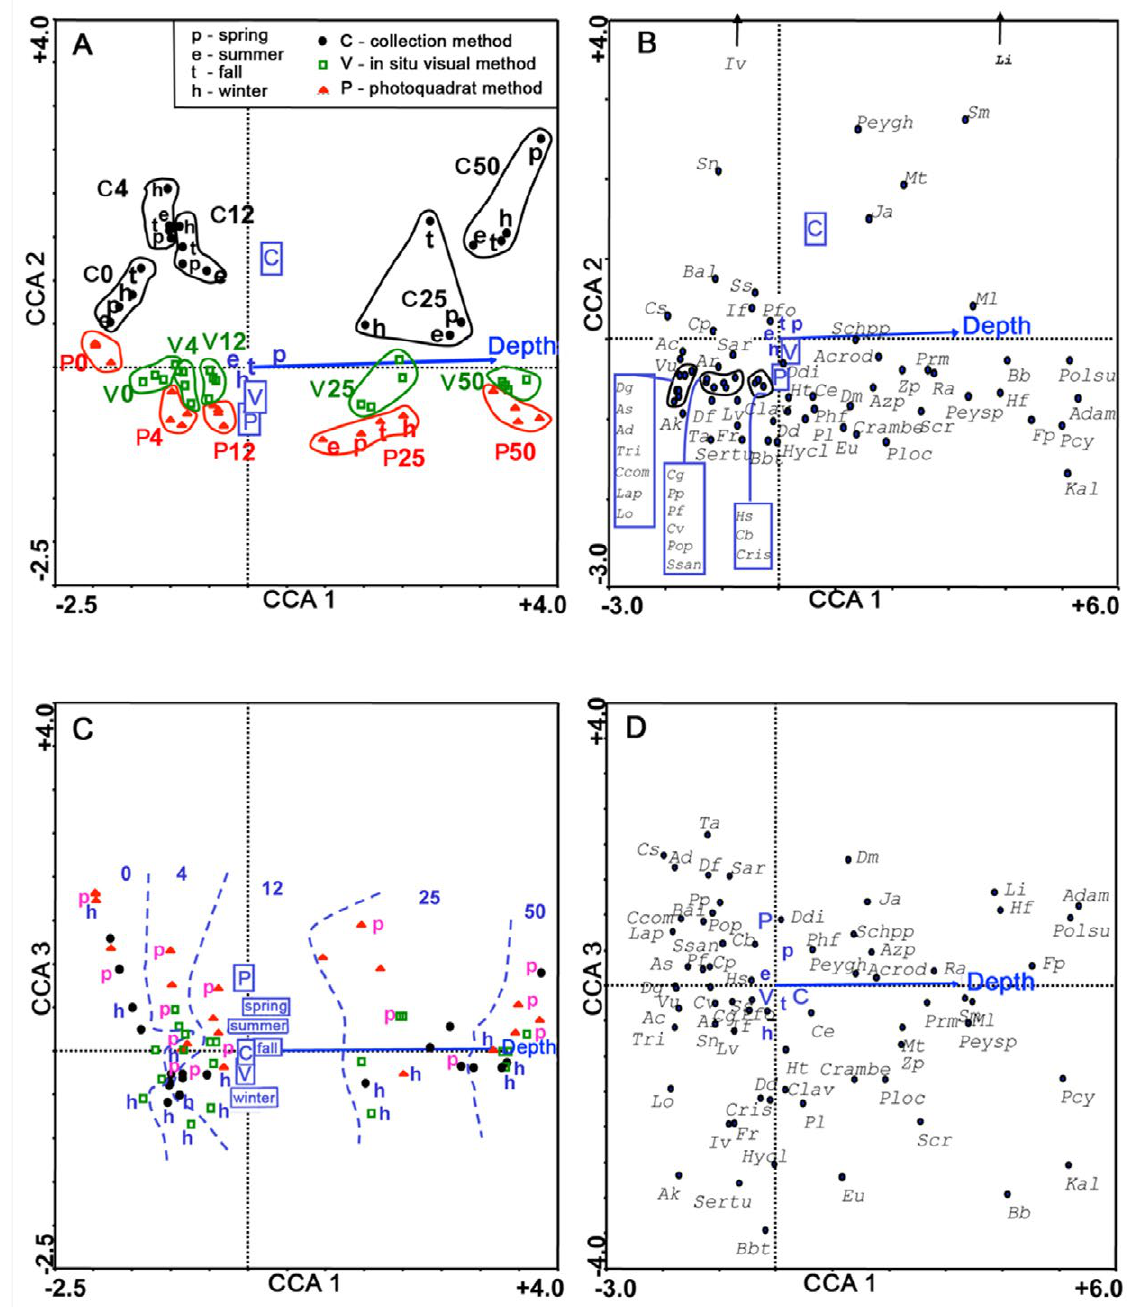
Fig. 4 – Ordination of the first three axes of the canonical correspondence analysis. A and C show sample ordination; B and D show species ordination. Numbers correspond to the depth in m. For example, C0 are replicates of the collection method (C) at 0 m deep and V50 are replicates of the photoquadrat method at 50 m deep. Species abbreviation as in Supplementary Material Tables S1, S2 and